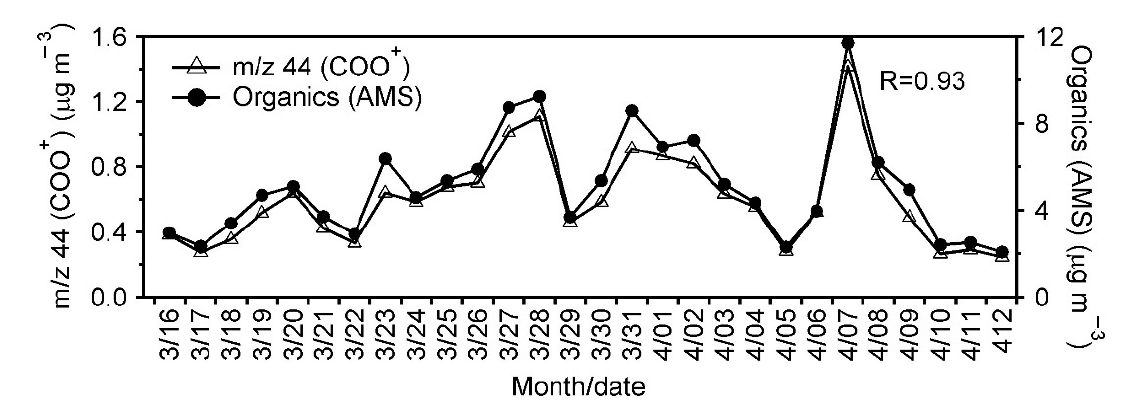
Figure 3. Temporal variations in organics and m/z 44 (COO + ) signal measured by AMS in aerosols samples collected from Okinawa.